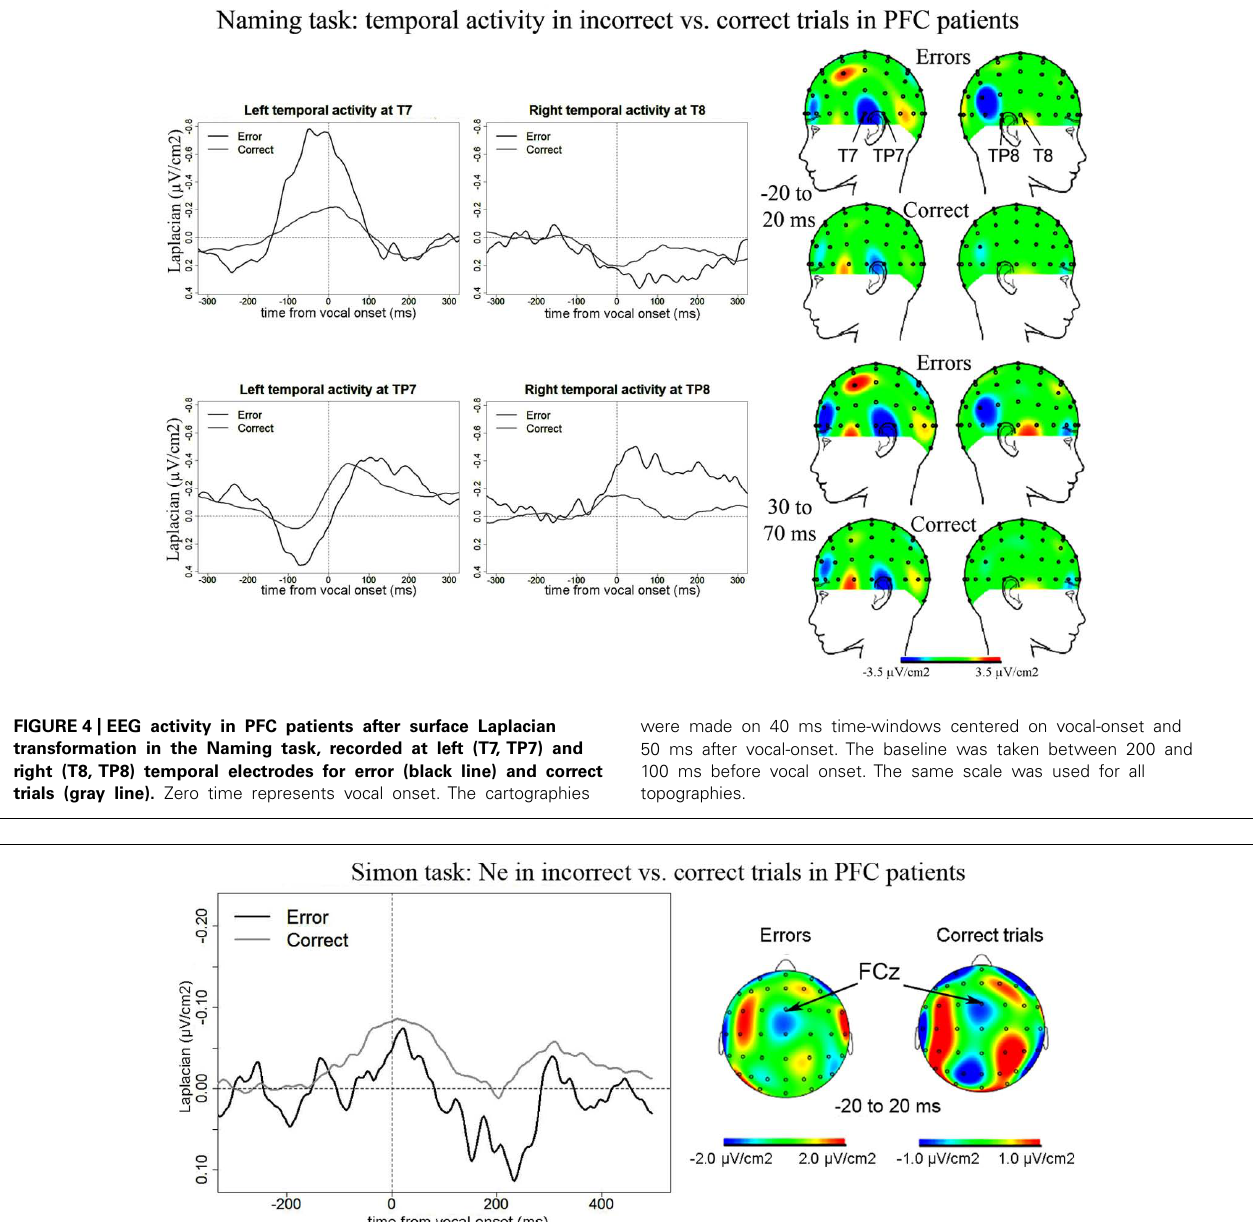
FIGURE 5 | EEG activity in PFC patients in the Simon task after surface Laplacian transformation, recorded at FCz for errors (black line) and correct trials (gray line). Zero of time represents vocal onset. Similarly as for